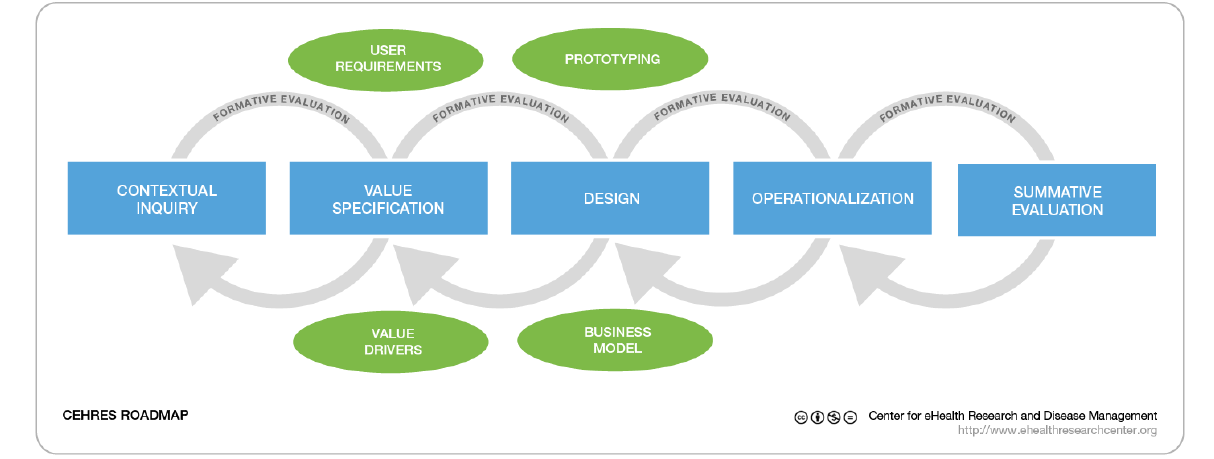
Figure 1. CeHRes Roadmap for the development of eHealth